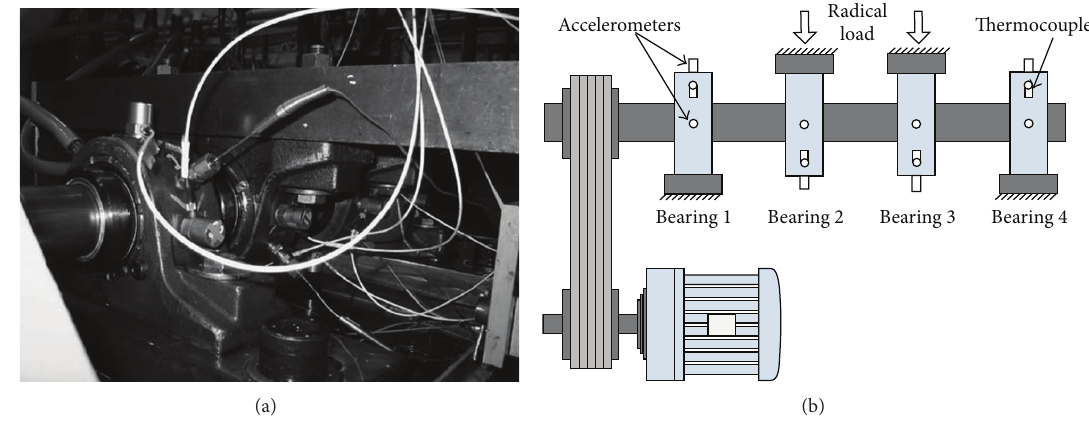
Figure 11: Bearing test platform and sensor placement illustration.